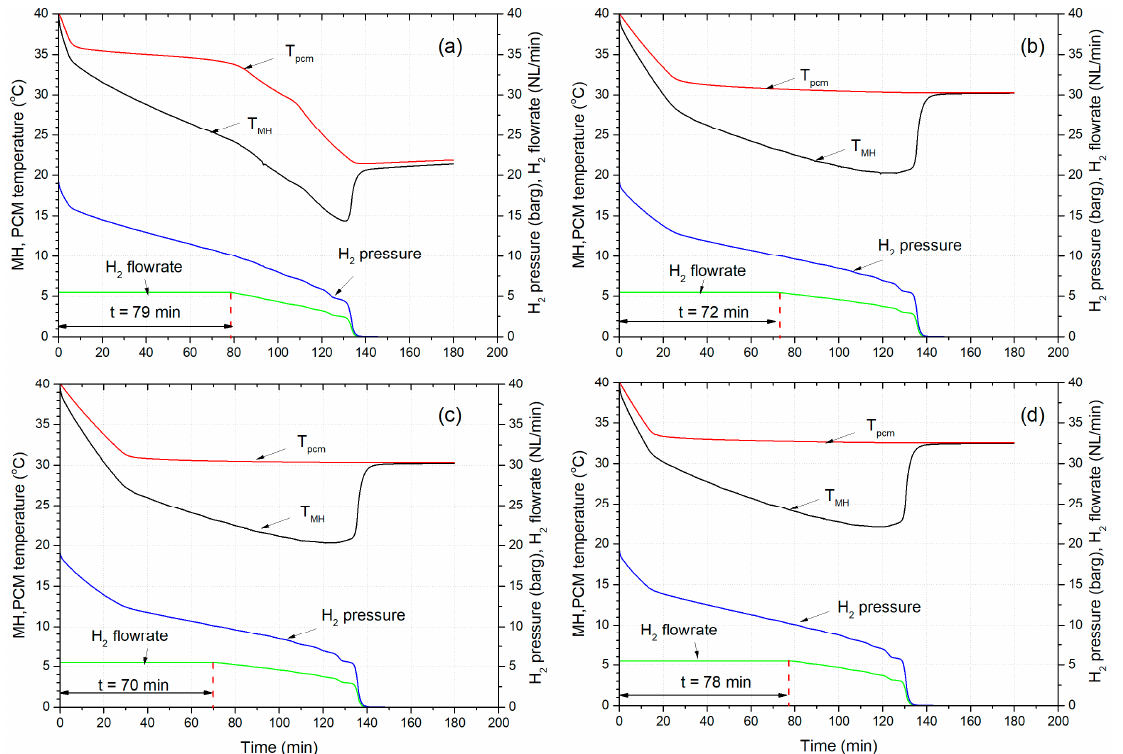
Figure 8. Temporal variation of PCM and MH bed temperature, H 2 gauge pressure and flowrate for different PCMs properties: ( a ) RT35, ( b ) SP29Eu, ( c ) LiNO 3 ∙ 3H 2 O, and ( d ) Na 2 SO 4 ∙ 10H 2 O.